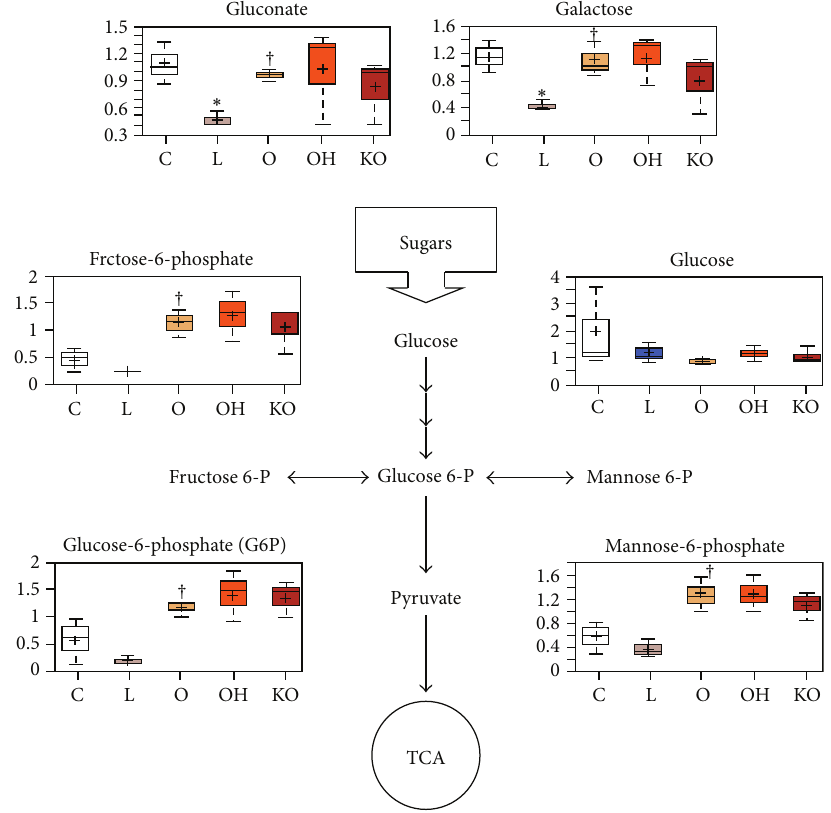
Figure 2: Variations in the hexose metabolites in HUVEC cell homogenates ( 𝑛 = 3 , for each experiment). Endothelial cells were incubated over 24 h with 50mg/L isolated human LDL (L); 50mg/L oxidized LDL (O); 50 mg/L oxidized LDL + 40mg/L HDL from wild type mice (OH); 50mg/L oxidized LDL + 40mg/L HDL from PON1 (−/−) mice (KO); or with serum-free media as controls (C). ∗ 𝑃 < 0.05 with respect to C; † 𝑃 < 0.05 with respect to